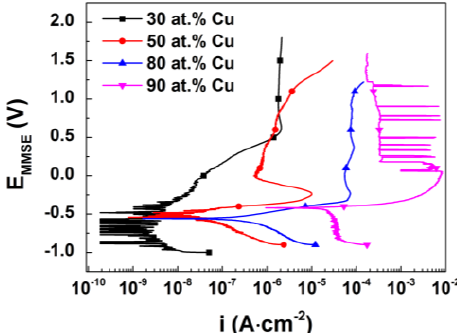
Figure 3. Potentiodynamic polarization curves of Zr-Cu glassy coatings after holding 16 h open circuit potential (OCP) in 0.01 M deaerated H 2 SO 4 solution at ambient temperature.